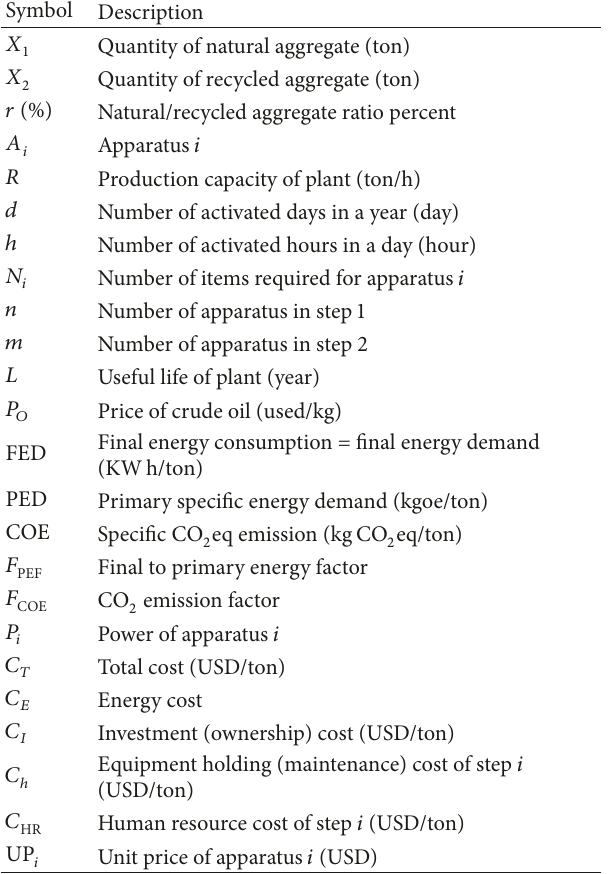
Table 2: Symbols used in this study for